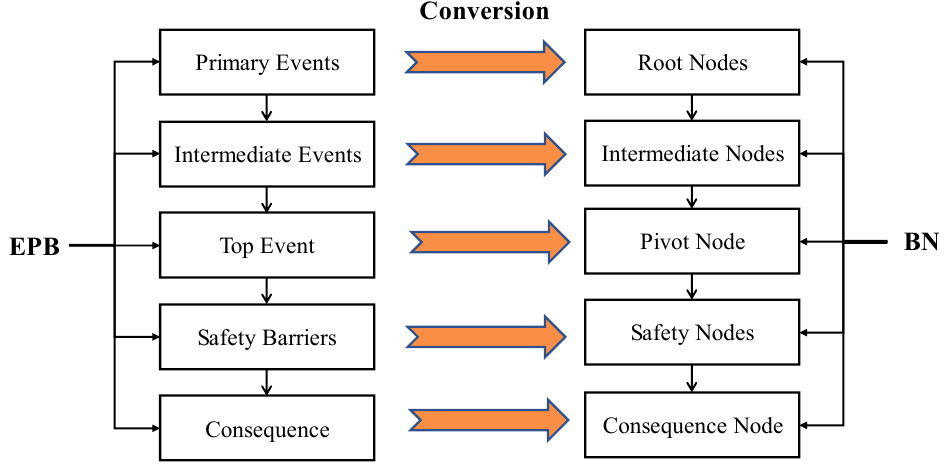
Figure 2. Conversion from EPB to BN (based on Khakzad, 2013